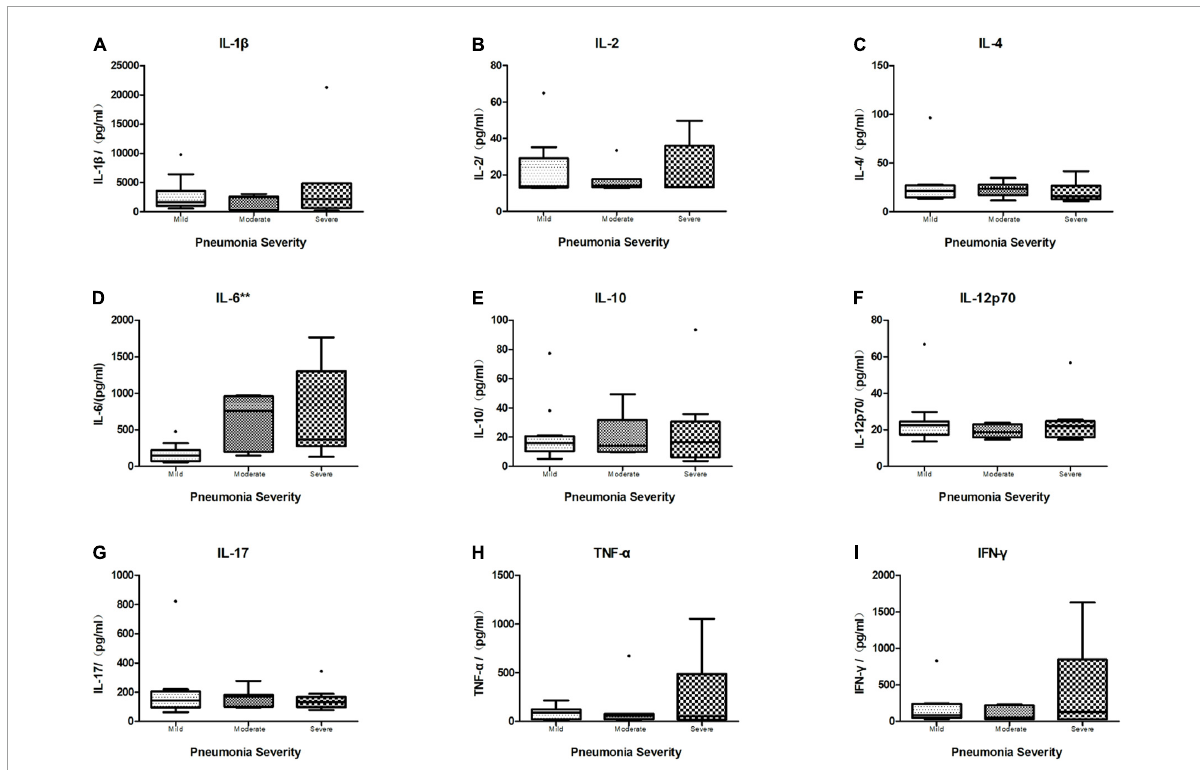
FIGURE6 Boxplot of comparison of cytokine levels in BALF of different severity categories. The median cytokine concentration is represented by the middle line in each box. The lower and upper borders of the box represent the 25th and 75th percentiles, respectively. Only IL-6 (D) in BALF showed a significant difference within different severity categories ( N = 28, Kruskal–Wallis test: p = 0.004, p < 0.01), while other cytokines revealed no significant difference within three groups ( N = 28, Kruskal–Wallis test. (A) IL1 β : p = 0.612, p > 0.05. (B) IL-2: p = 0.949, p > 0.05. (C) IL-4: p = 0.619, p > 0.05. (E) IL-10: p = 0.957, p > 0.05. (F) IL-12p70: p = 0.682, p > 0.05. (G) IL-17: p = 0.743, p > 0.05. (H) TNF- α : p = 0.784, p > 0.05. (I) IFN- γ : p = 0.834, p > 0.05). ** p < 0.01.